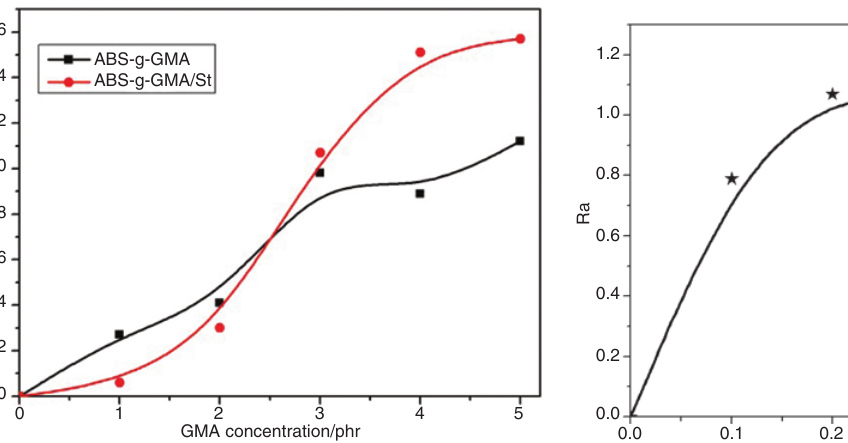
Figure 5 Effect of GMA concentration on the GD by FTIR.